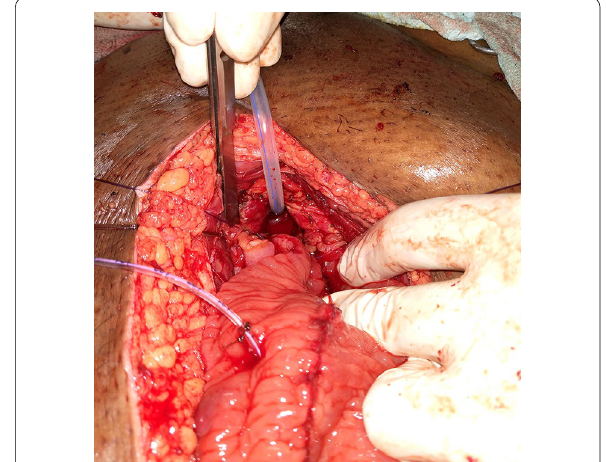
Fig. 11 Augmentation using ileum